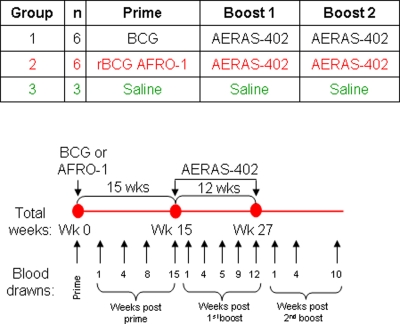
Study Timeline and Sampling Schedule.NHPs were boosted with AERAS-402 fifteen and twenty-seven weeks after the prime with BCG or AFRO-1, Animals in group 1 were primed with BCG, animals in group 2 with the recombinant BCG (AFRO-1) which combines endosomal escape, TB10.4 expression and over-expression of Ag85A and Ag85B. Animals in both groups were boosted with the non-replicating adenovirus 35 AERAS-402 which expresses the Ag85A, Ag85B and TB10.4 fusion protein. Animals in group 3 received the diluent (control group).